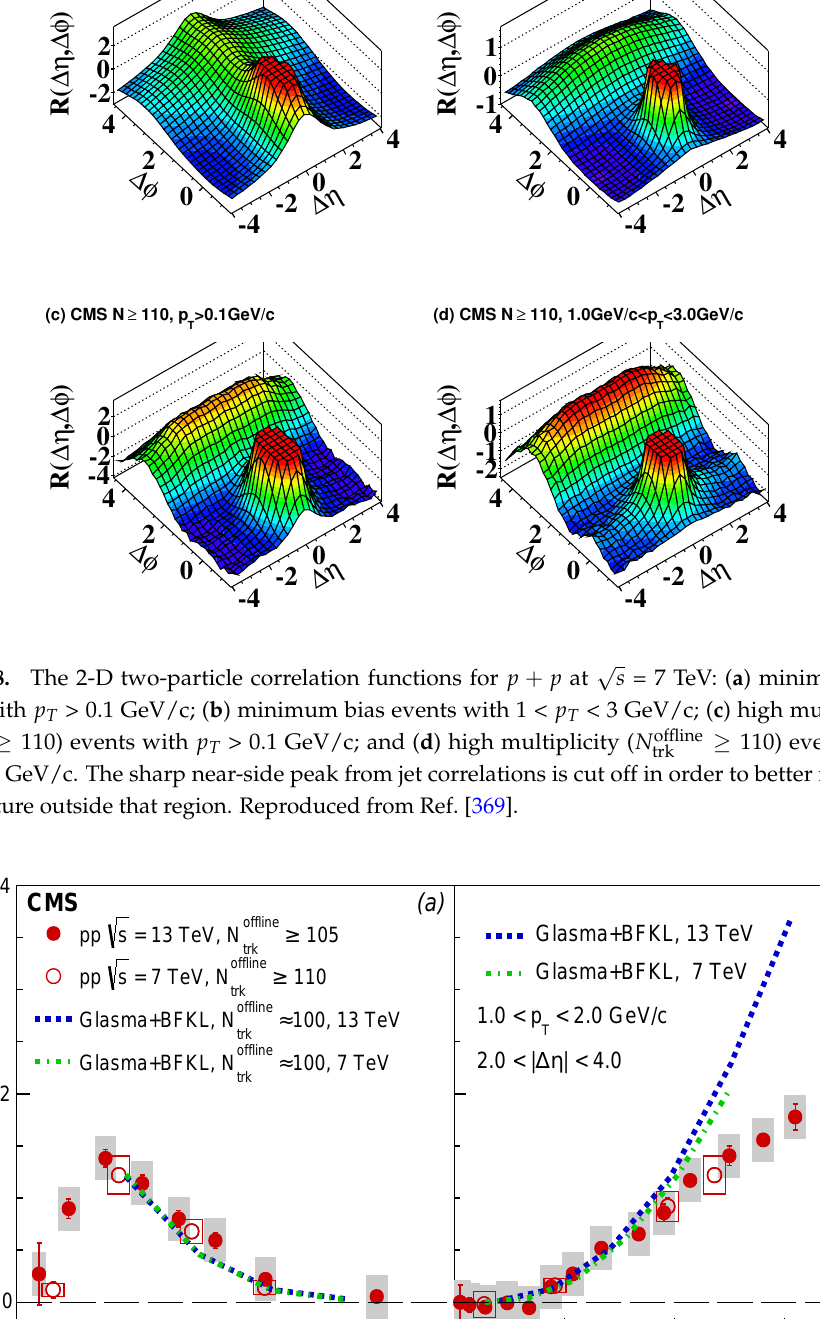
Figure 29. The associated yield for the near-side of the correlation function averaged over 2 < | ∆ η | < 4 √ s = 13 TeV (filled circles) and 7 TeV (open circles) [370]. Panel ( a ) shows the for p + p data at ≥ 105. In panel ( b ), the associated yield associated yield as a function of p T for events with N offline trk for 1 < p T < 2 GeV/c is shown as a function of multiplicity—N offline . The p T selection applies to both trk particles in each pair. Curves represent the predictions of the gluon saturation model